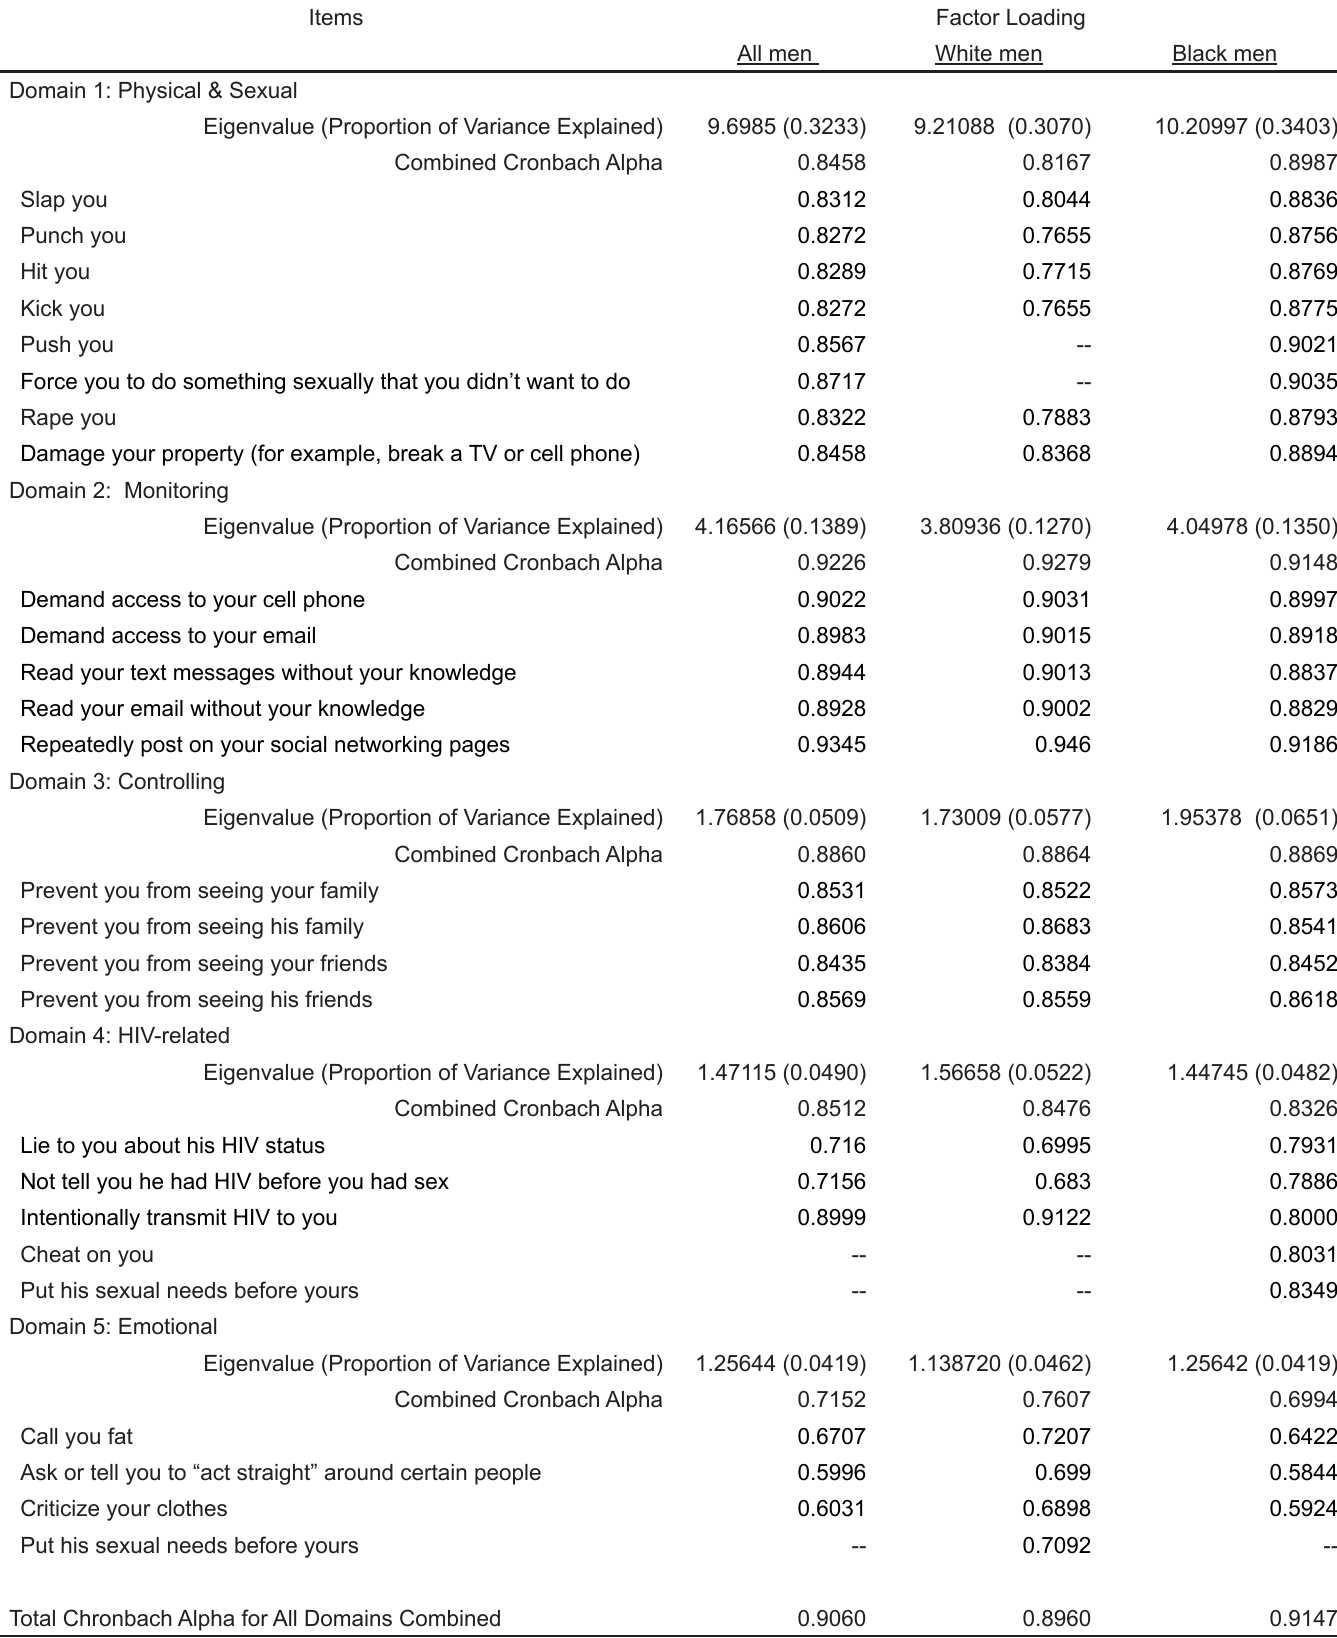
Table 1: Factor analysis of definitions of intimate partner violence among gay and bisexual men. Data are from a venue-based self- completed survey with gay and bisexual men, 2011 (N=912). Items Factor Loading All men White men Black